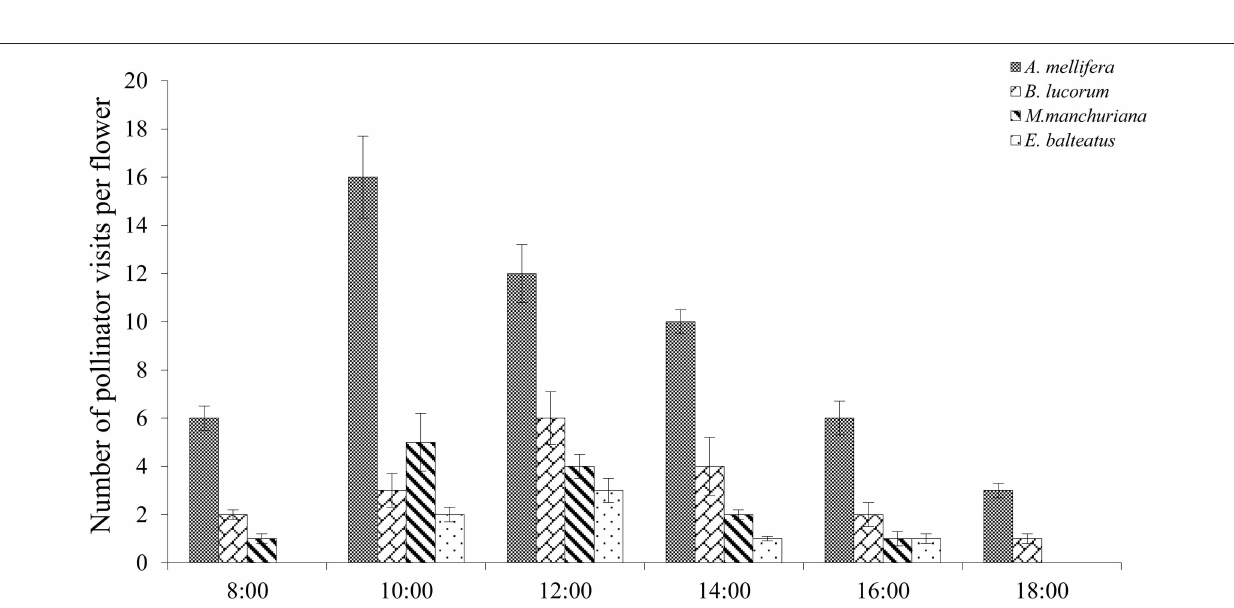
FIGURE 5 | Frequency of dominant pollinator visits to C. microphylla